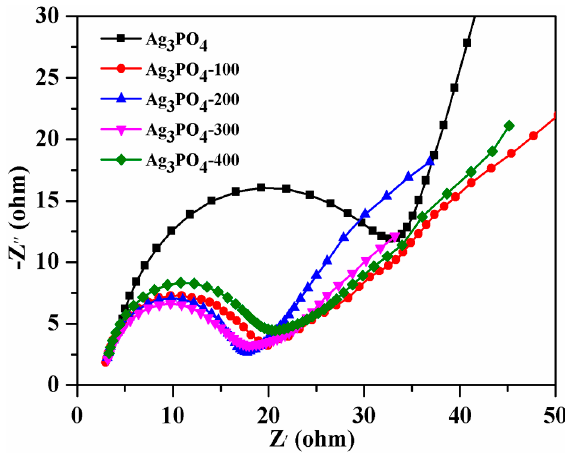
Figure 10. EIS Nyquist plots of the electrodes prepared by pristine and calcined Ag 3 PO 4 samples under visible light irradiation.